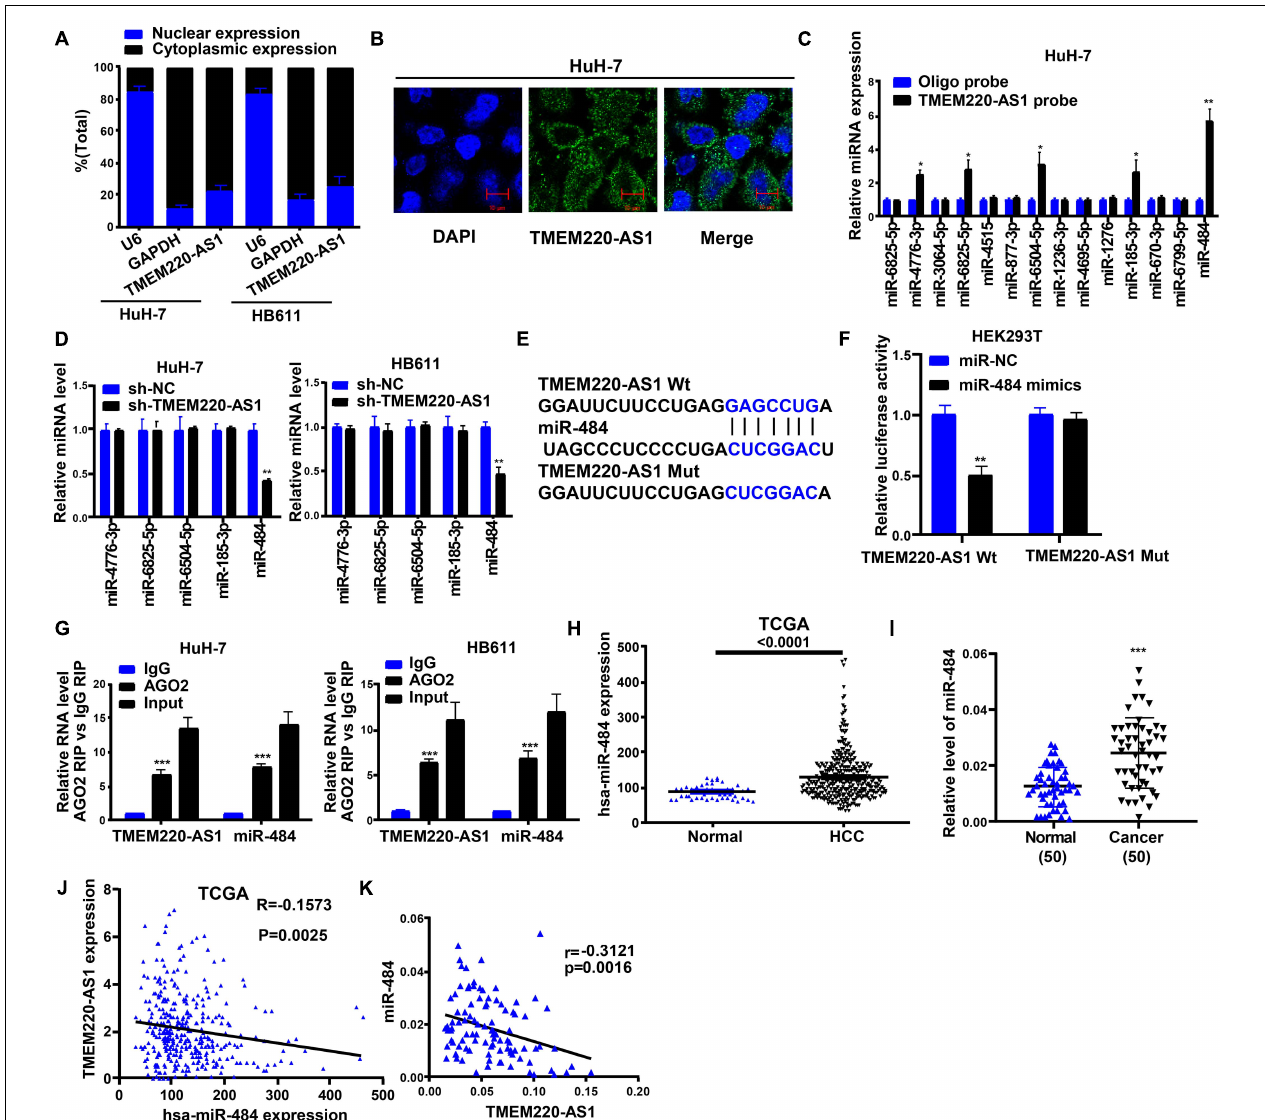
FIGURE 4 | TMEM220-AS1 is targeted by miR-484. (A,B) Localization of TMEM220-AS1 by nucleocytoplasmic separation experiment and RNA-FISH in HCC cells (bar = 10 µ m). (C) The relative expression of candidate miRNAs which could potentially bind to TMEM220-AS1 were quantified by qRT-PCR after the biotinylated- TMEM220-AS1 pull-down assays in HuH-7 cells. (D) The levels of miRNAs after TMEM220-AS1 cutdown were tested by qRT-PCR. (E) Putative miR-484 binding sequence and mutation sequence of TMEM220-AS1 mRNA were as shown. (F) Dual luciferase reporter assays were used to confirm the direct target between TMEM220-AS1 and miR-484. (G) RIP assay was used to detect whether miR-484 could bind with TMEM220-AS1. (H) miR-484 expression in HCC samples and normal samples, from TCGA database. (I) The correlation analysis between miR-484 expression and TMEM220-AS1 expression in HCC samples and normal samples, from TCGA database. (J) miR-484 expression in HCC tumor tissues and adjacent non-tumorous tissues. (K) The correlation analysis between miR-484 expression and TMEM220-AS1 expression in HCC tumor tissues and adjacent non-tumorous tissues, from our dataset. Data were presented as represent the mean ± SD; * P < 0.05, ** P < 0.01, *** P < 0.001.